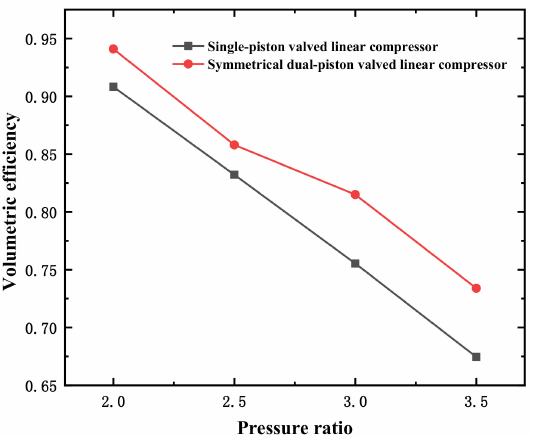
Figure 17. The volumetric efficiencies of the two types of linear compressors at different pressure ratios, obtained from the